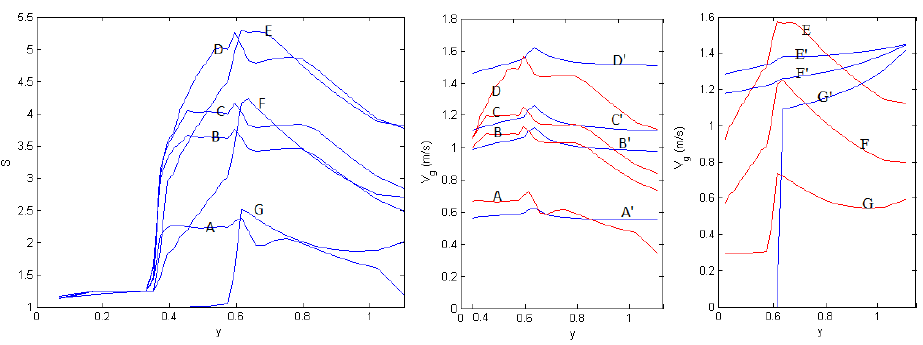
Figure 6. Slip velocity and gas